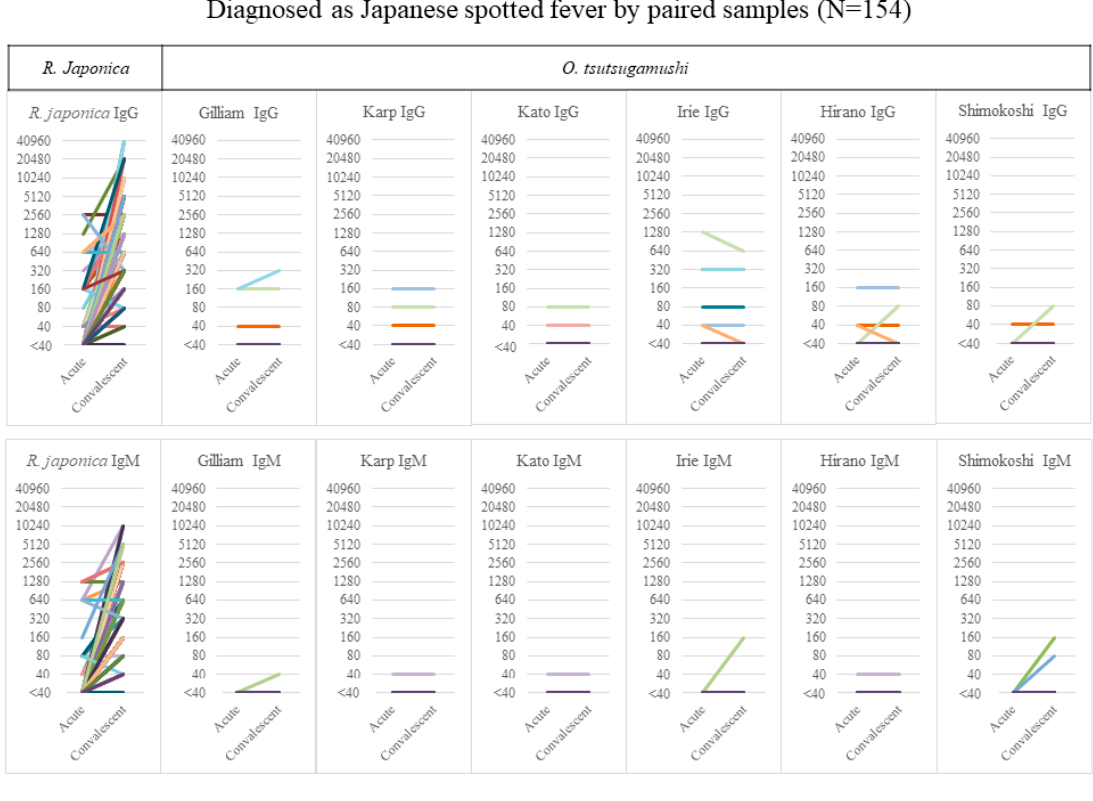
Table 1. Summary of the tested cases for Japanese spotted fever and scrub typhus.